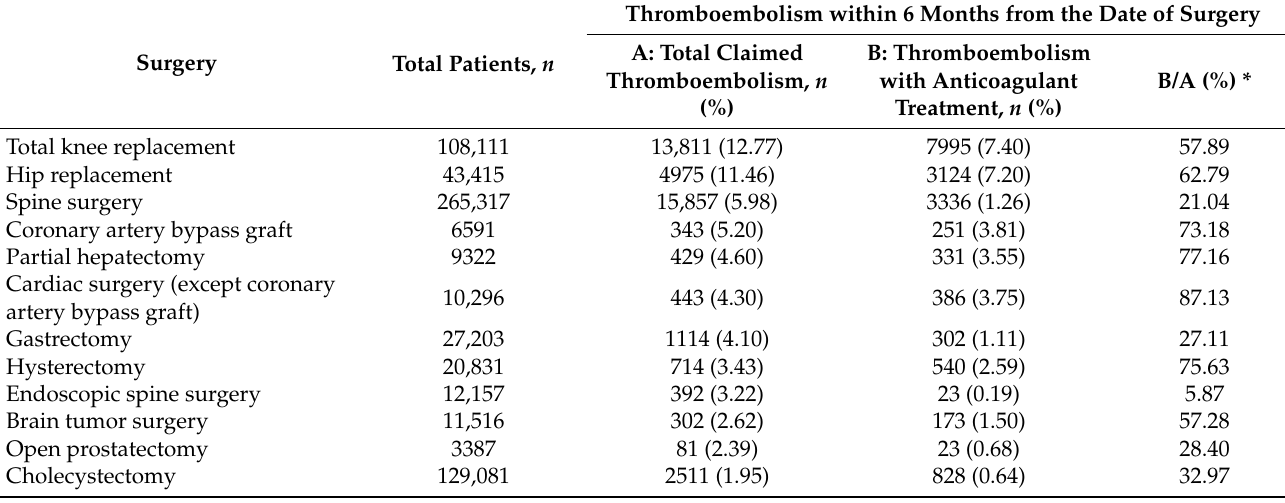
Table 1. Incidence of thromboembolism within 6 months from the date of each